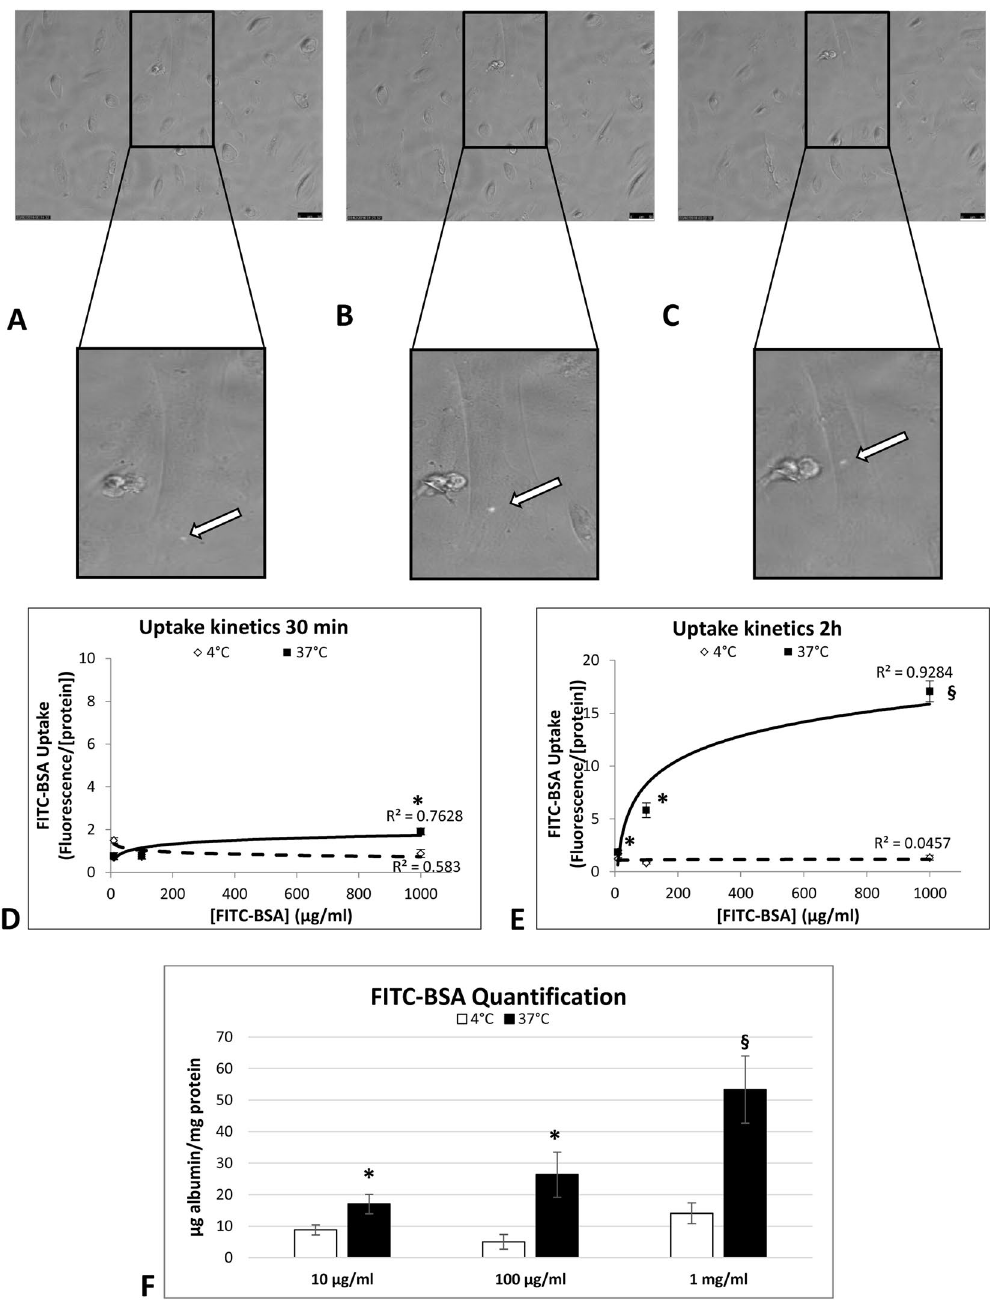
Figure 1. Podocytes perform receptor-mediated uptake of albumin even at low doses. Time lapse experiments disclosed the ability of podocytes to internalize albumin (FITC-BSA 10 µ g/ml). Representative images show vesicles containing albumin (green) at different time points: 5 h 30 min ( A ), 6 h 39 min ( B ), 8 h 18 min ( C ). The white arrow follows the movement of one vesicle from the periphery of the cell to the perinuclear region. Objective 20X/0.4. Scale bar 50 µ m. Albumin uptake follows receptor-mediated kinetics in human podocytes. At 30 minutes, only the 1 mg/ml concentration was significant ( D ); after 2 hours, FITC-BSA was significantly internalized at all doses tested by comparison with non-stimulated control cells ( E ). Albumin uptake increased until saturation at 37 °C (continuous line), with abolition of the process at 4 °C (dotted line). Graph F shows significant quantity of FITC-BSA internalized by podocytes at 37 °C comparing to 4 °C. Data are shown as the average ± SD of three different experiments in triplicate. * P < 0.05; § P <